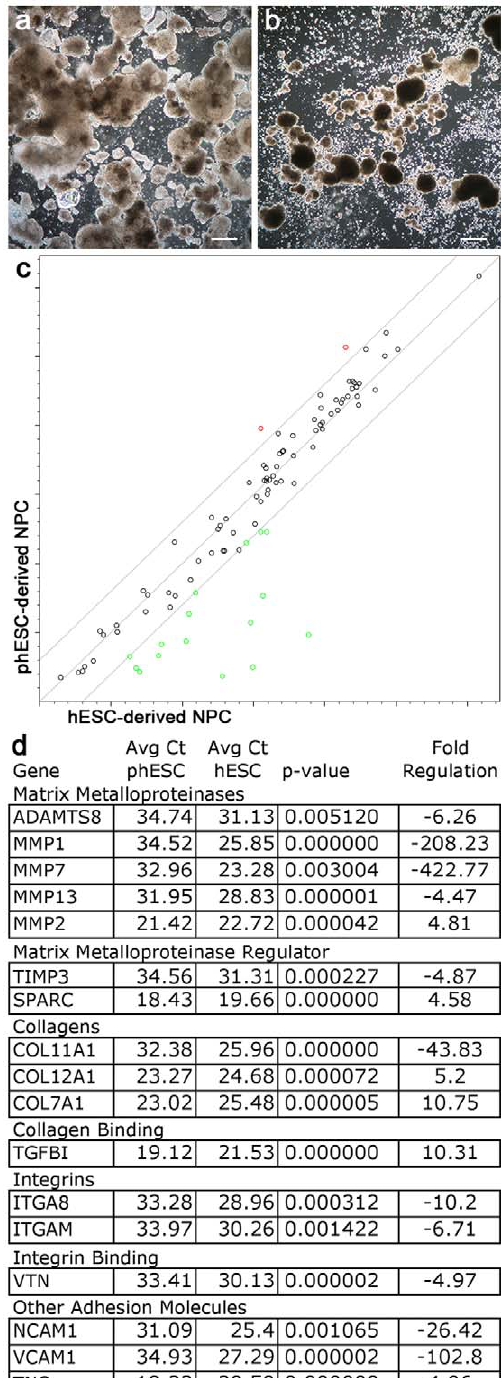
Figure 5. phESC display altered ECM profile and do not readily form spheres in non-adherent culture. During the sphere-forming stage of the NPC protocol, hESC gave rise to clusters that readily formed spheres with minimal dissociation (a). phESC at the same stage consistently dissociated (b). PCR arrays revealed differences in extracellular matrix and adhesion molecules in NPC (c). Parthenote- derived lines LLC6P and LLC8P are plotted on the y-axis and conventionally-derived lines H7 and CSC14 on the x-axis. Details of differentially expressed genes are presented numerically (d). Western blot analysis confirmed differential expression of NCAM1 (e). Scale bars represent 20 m m